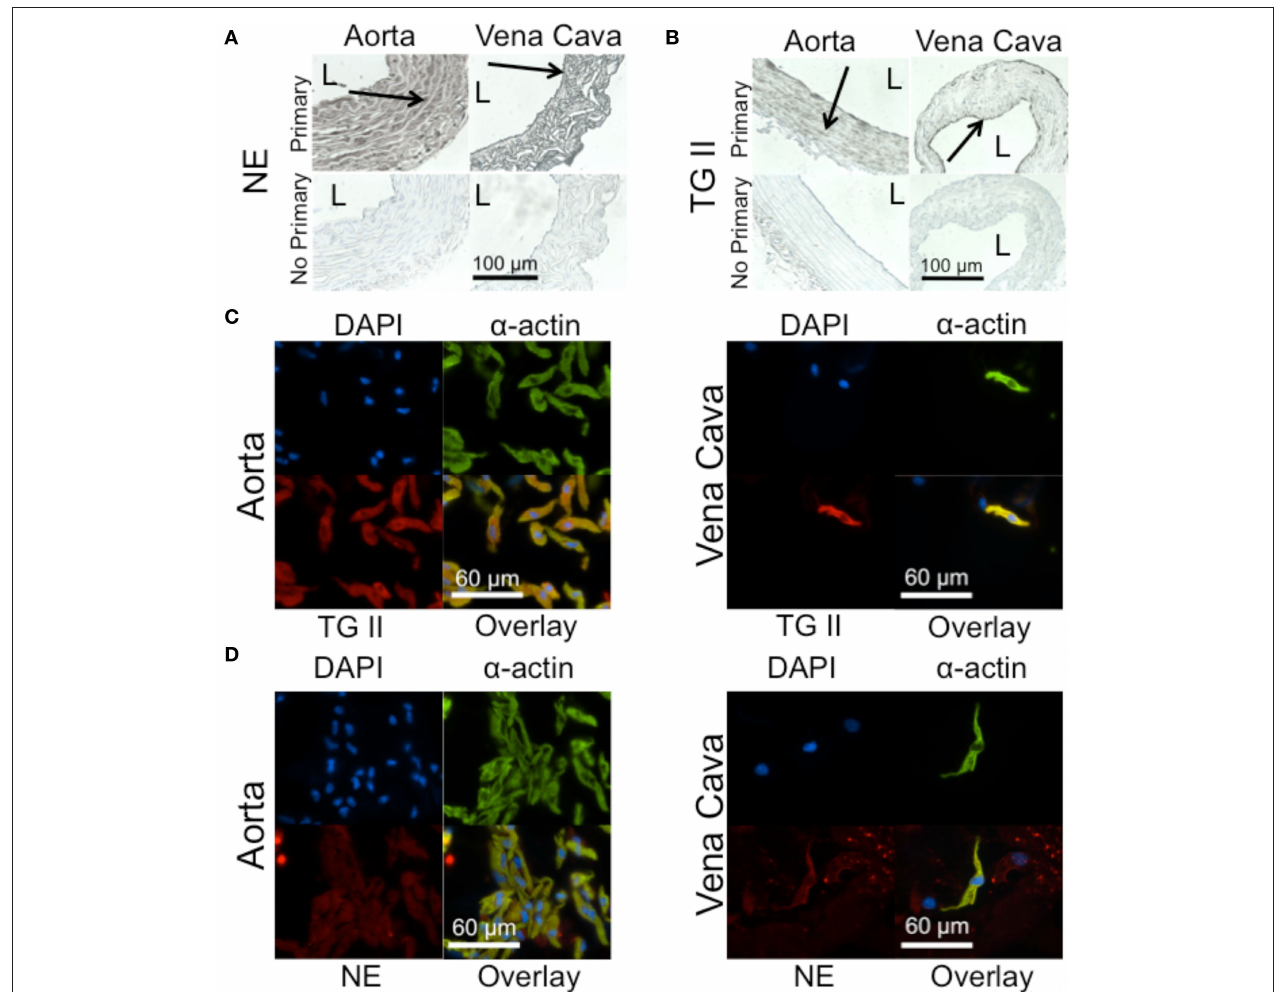
Figure 2 | Tg ii and Ne are present in aorta and vena cava tissues. (A) Immunohistochemical staining of NE in a rat aorta (left) and vena cava (right). L = lumen. Arrows point to areas of staining. (B) Immunohistochemical staining of TG II in the rat aorta (left) and vena cava (right). (C) Immunocytochemical staining of TG II (red) in freshly dissociated smooth muscle cells of the aorta (left)